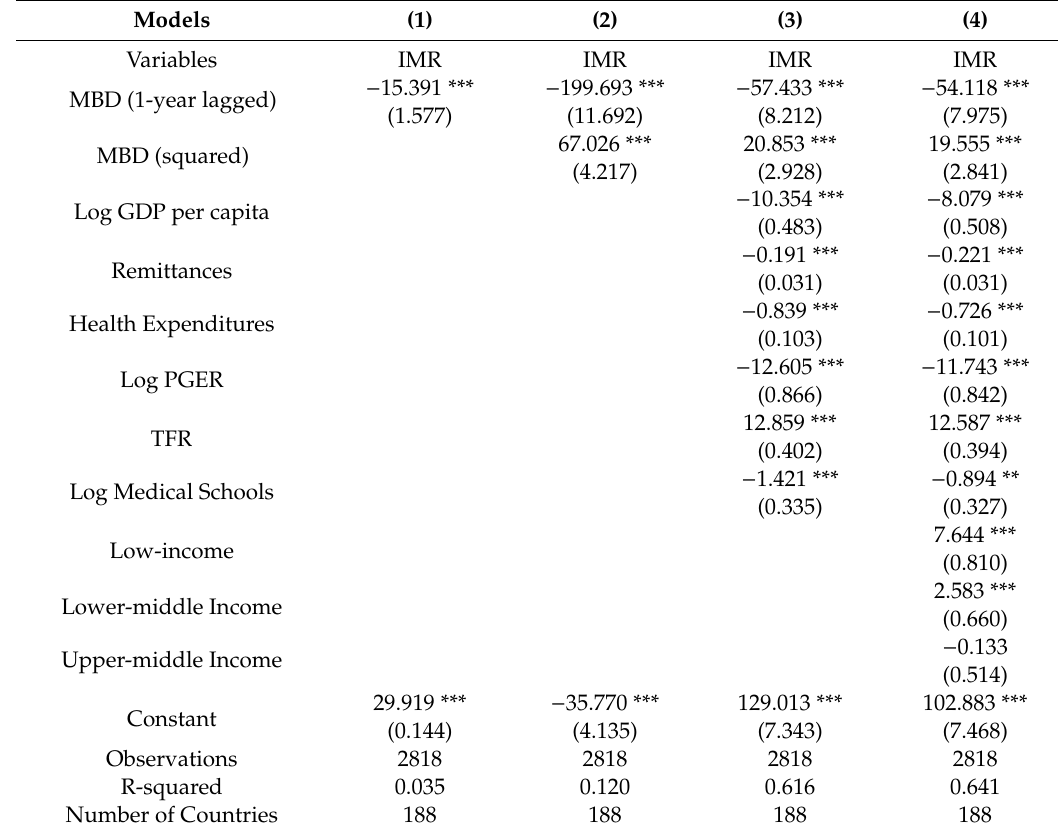
Table 4. Fixed-e ff ects regression of MBD (1-year lagged) on IMR in 188 countries over